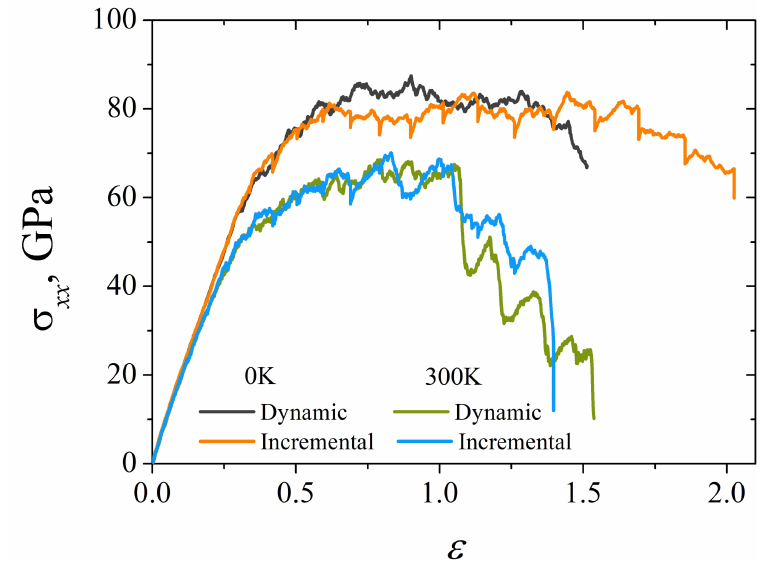
Figure 9. Stress–strain curves during uniaxial tension for dynamic (black and green curves) and incremental (orange and blue curves) deformation at 0 and 300 K. Strain rate is ˙ ε = 5 × 10 − 3 ps − 1